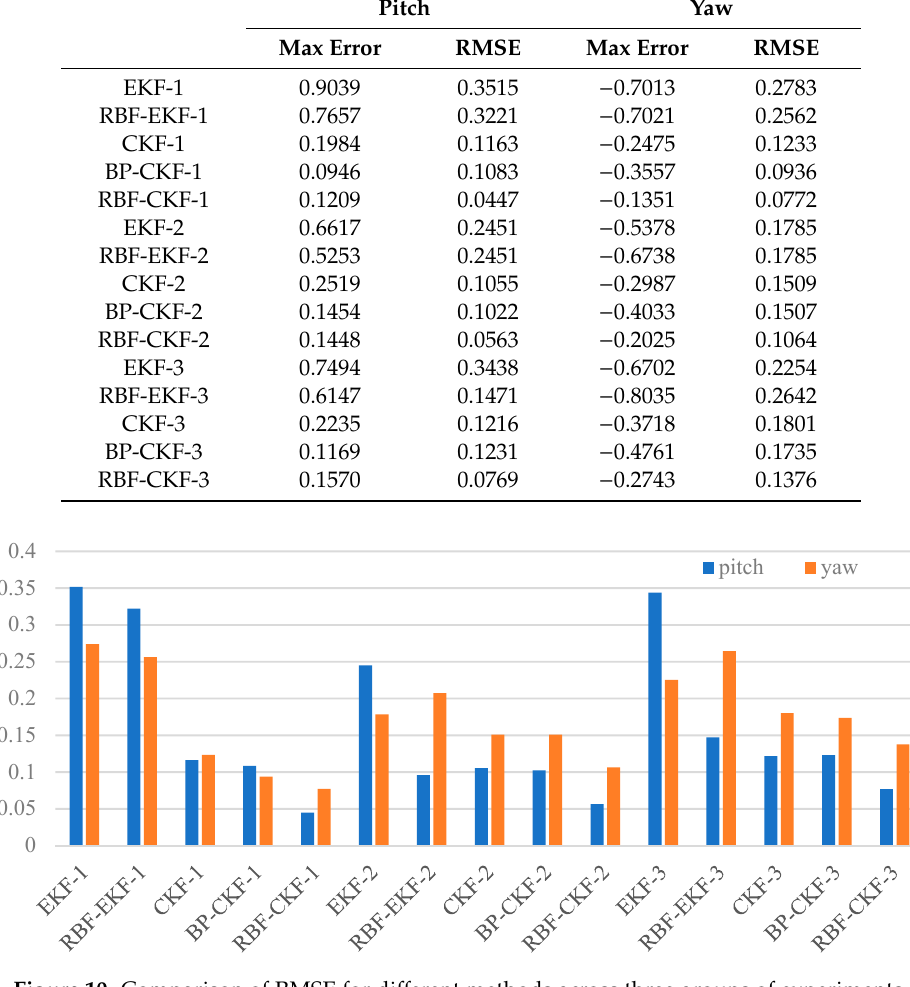
Figure 10. Comparison of RMSE for different methods across three groups of experiments. Table 3. Running time of five methods.